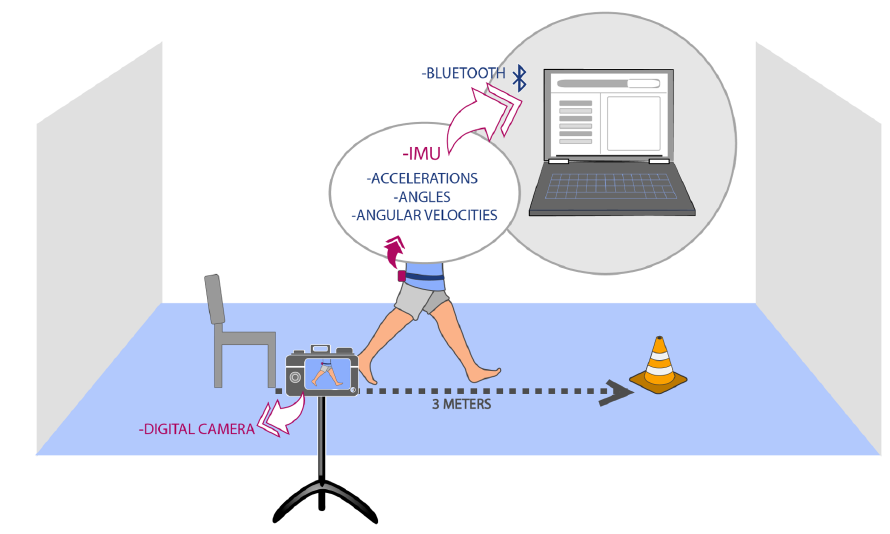
Figure 3. Set up used for the acquisition data during 3-m TU & Go test.